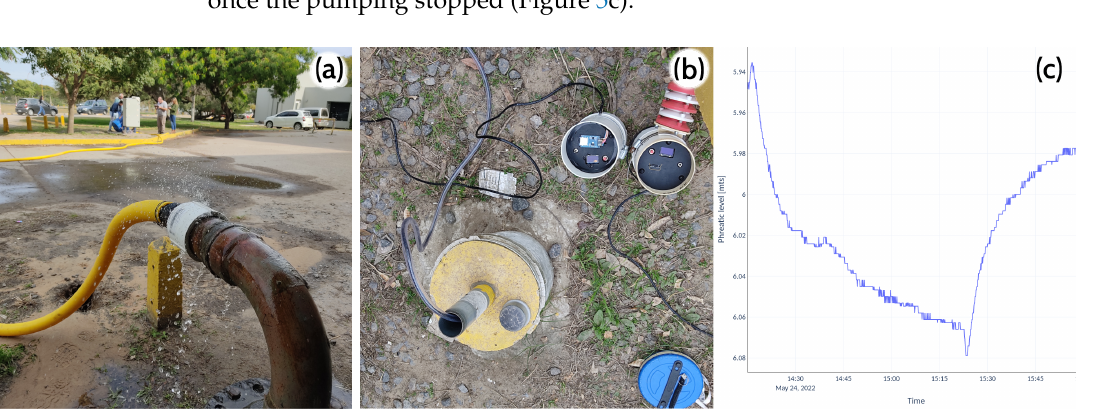
Figure 5. ( a ) Running the pumping test at FICH; ( b ) the observation well where the pressure sensor was connected to the datalogger; ( c ) the collected data vs